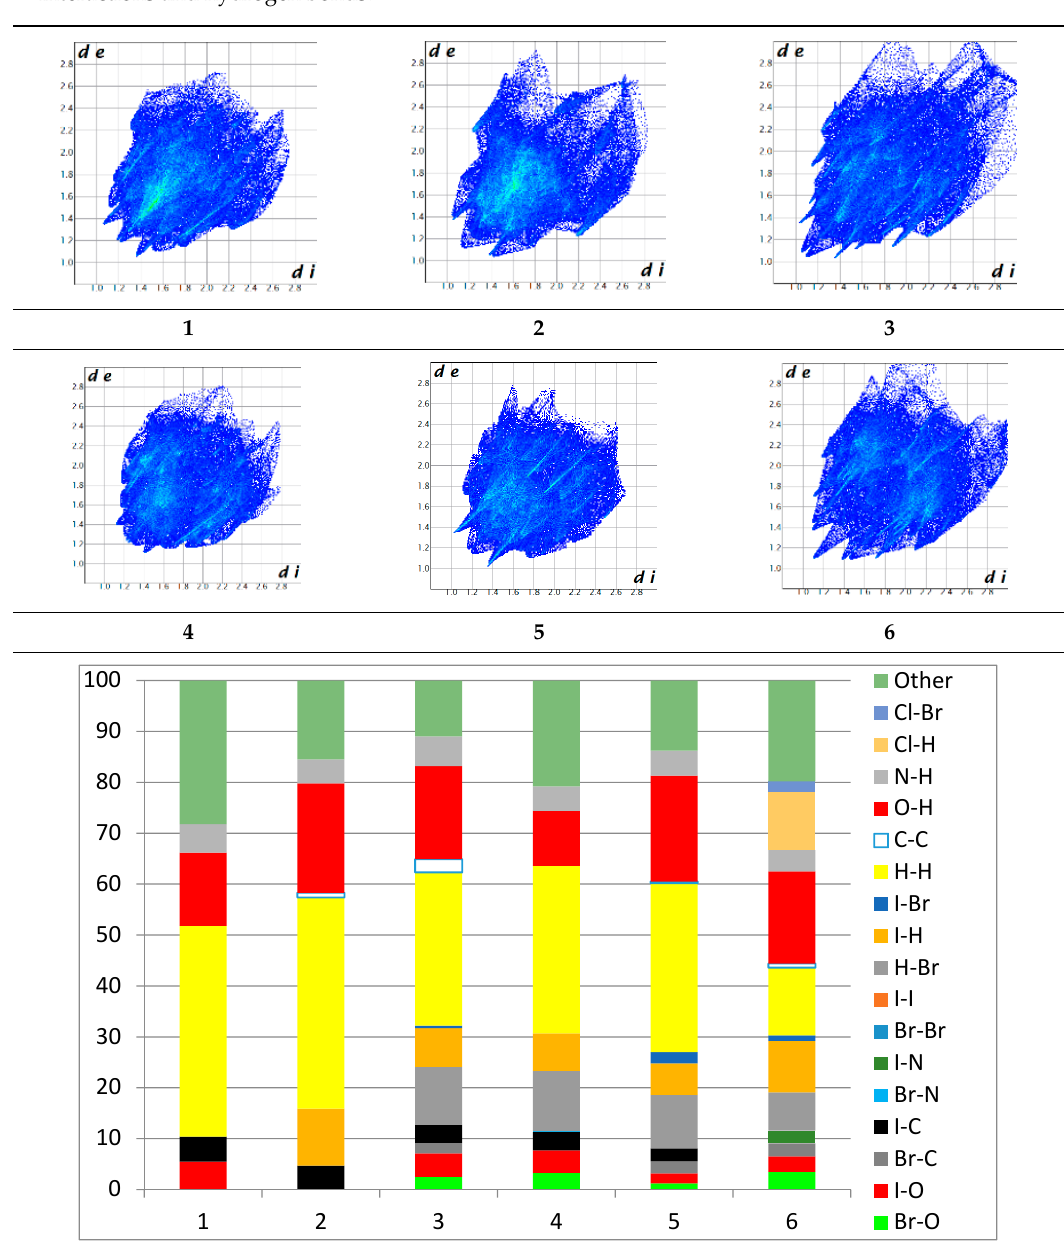
Table 2. Fingerprint plots of compounds 1 – 6 showing the most important interactions: halogen interactions and hydrogen bonds.